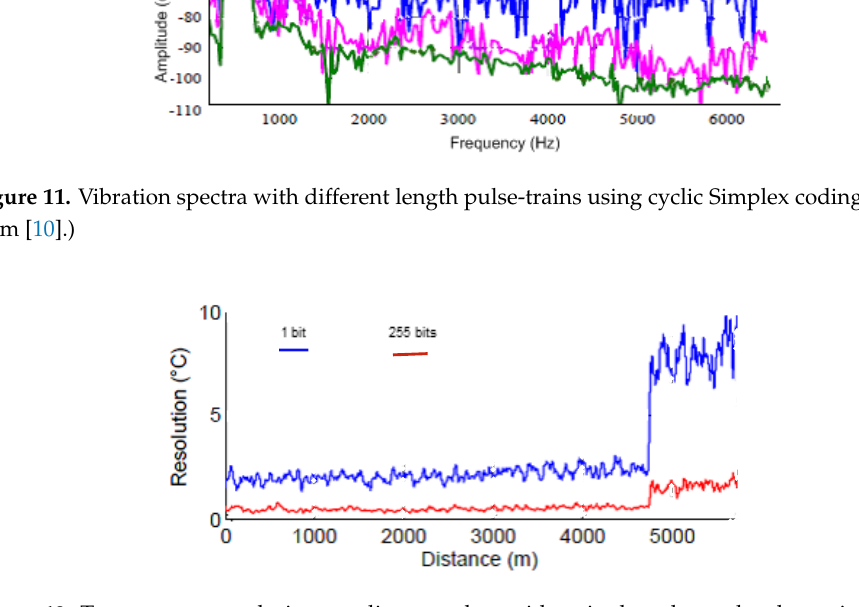
Figure 12. Temperature resolution vs. distance plots with a single pulse and pulse-train. (Adapted from